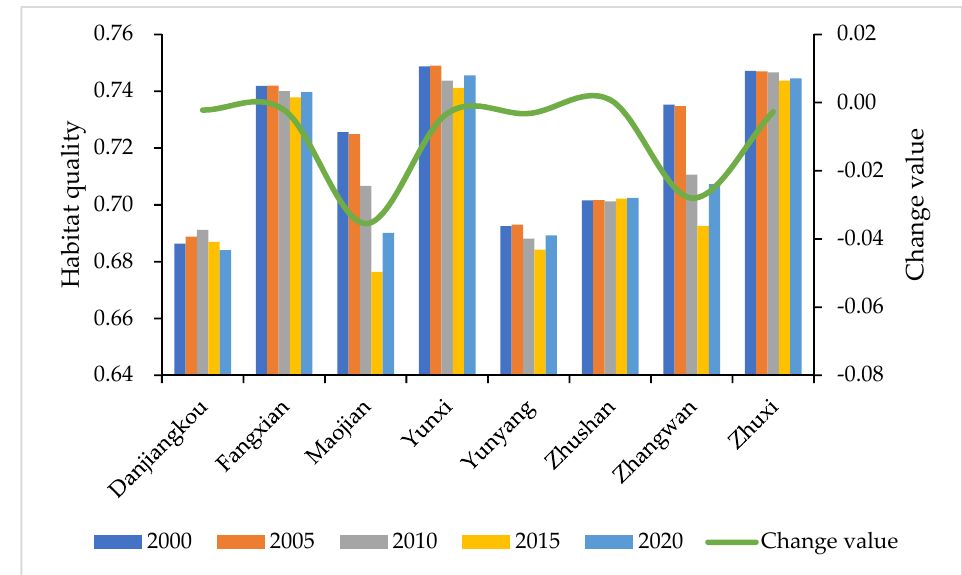
Figure 6. Habitat quality change in counties of Shiyan from 2000 to 2020.